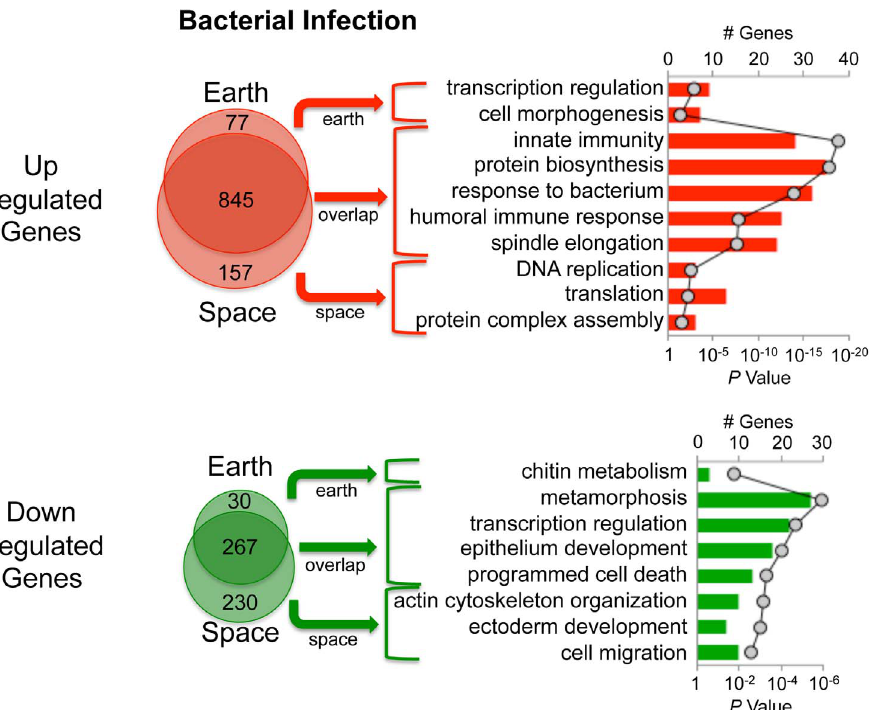
Figure 5. Microarray-based analysis of response to E.coli . The total number of genes upregulated or downregulated in Earth flies only (Earth) or space flies only (space) or in both (overlap) are indicated by Venn diagrams. Pathway analysis is shown on the right side of the figure. The number of genes in each functional category is depicted in bar graphs (primary y-axis), and the P values corresponding to statistical over-representation of each category are presented as a line graph (secondary y-axis).